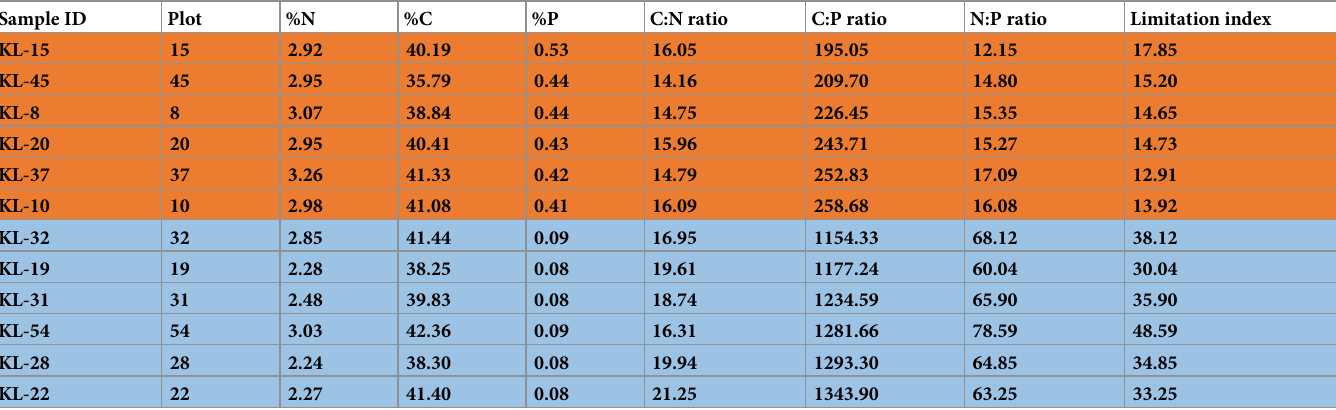
Plot number refers to plots described in Campbell et al 2018. Limitation index describes the relative divergence from the ideal N:P ratio for Thalassia testudinum (near 30:1). Orange: Plants with high P content, blue: plants with low P